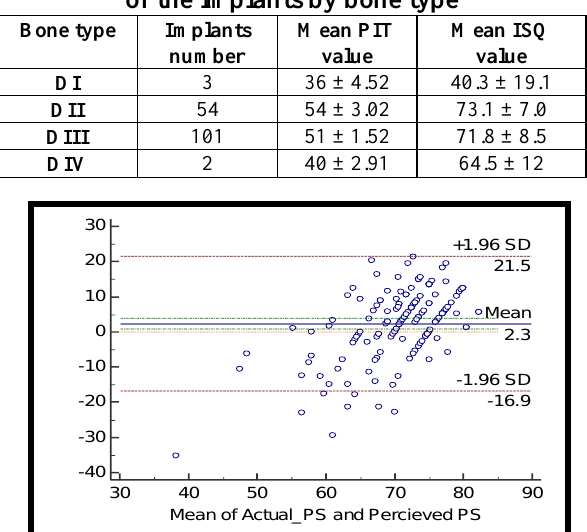
Figure 4: Bland–Altman plot for the fixed biased for the two measurements of primary stability (actual and